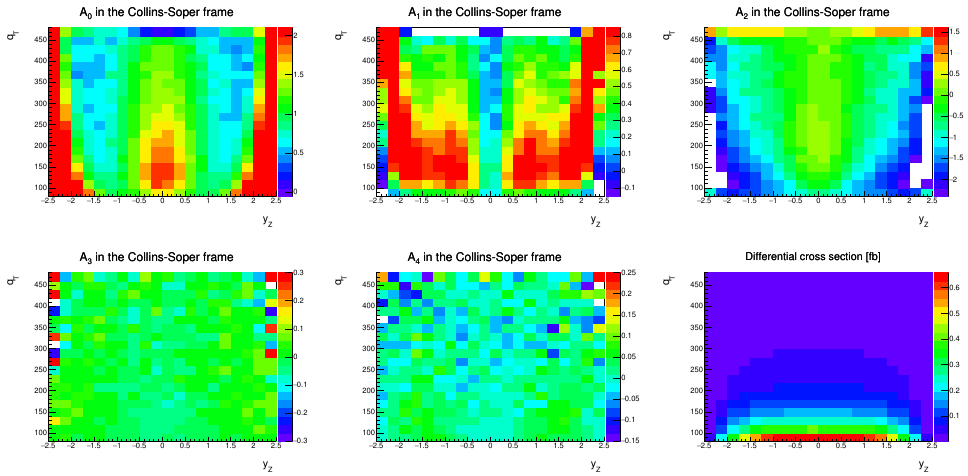
Figure 13 . Angular coe(cid:14)cients A 0 background only hypothesis. Selections in table 4 have been applied and cause irregular shapes in kinematic boundaries.